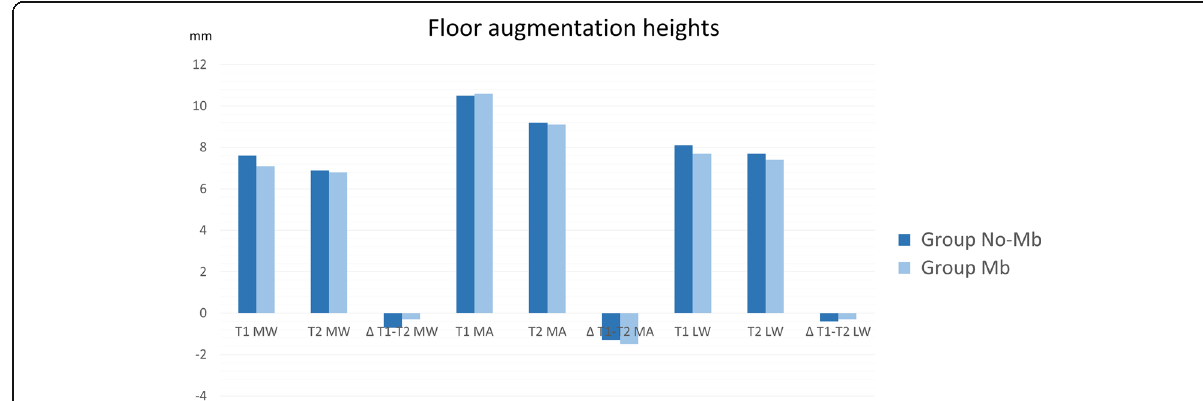
Fig. 6 Graph representing floor augmentation and loss ( Δ ) of heights between 1 week (T1) and 9 months (T2) in the coronal plane evaluated at the medial (MW), middle (MA), and lateral (LW) walls of the sinus. Data in